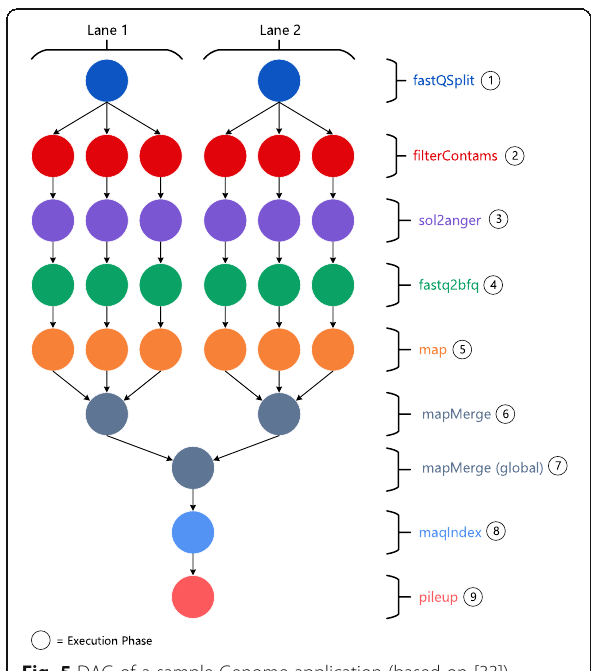
Fig. 5 DAG of a sample Genome application (based on